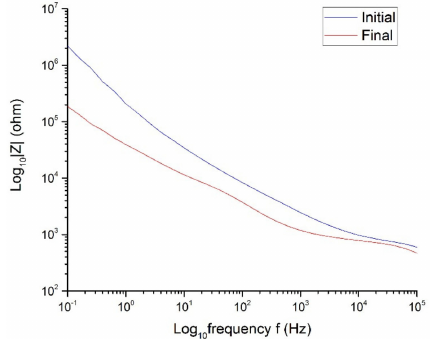
Figure 15. Impedance of the Pt cu ff electrode G in NaCl at room temperature.